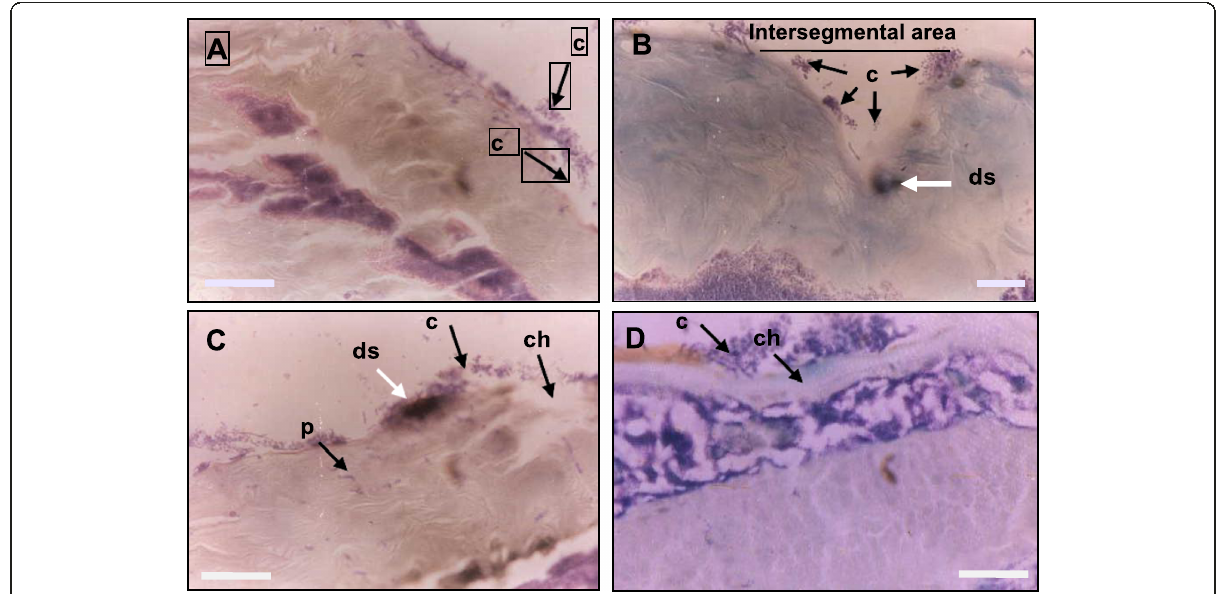
Fig. 3 Cross sections of Zeuzera pyrina larva infected with Beauveria bassiana showing the parasitic phase of the fungus. a Conidial aggregations on the epicuticle and its chitinolytic activity. b Aggregates of conidia mainly at the intersegmental area with dark spots. c Progression in penetration process showing penetrant hypha, dark spots and chitinolytic activity. d Progression in chitinolysis process and conidial aggregations. c, conidia; ch, chitionlytic activity; p, penetrant hypha; ds, dark spots ( X =